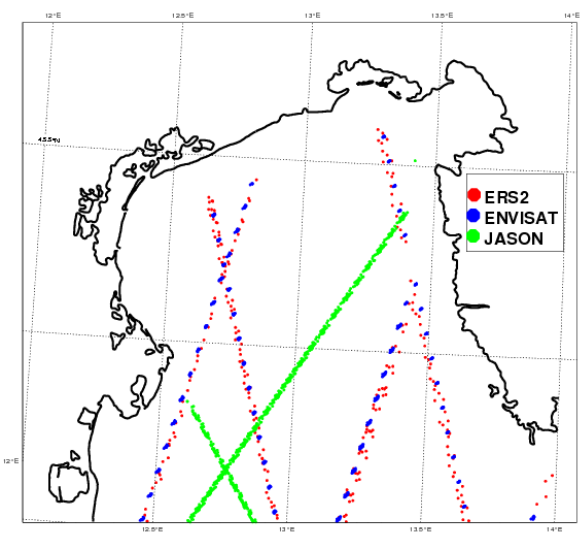
Fig. 10. Ground traces along which altimeter data is available in the Figure 10 – Ground traces along which altimeter data is available in the northern Adriatic. The northern Adriatic. The ERS-2 and ENVISAT satellites fly along the ERS-2 and ENVISAT satellites fly along the same orbit with a 30 day return period. Jason shows same orbit with a 30 day return period. Jason shows also the orbit also the orbit of Topex and Jason-2, with a ten day return period. of Topex and Jason-2, with a ten day return period.